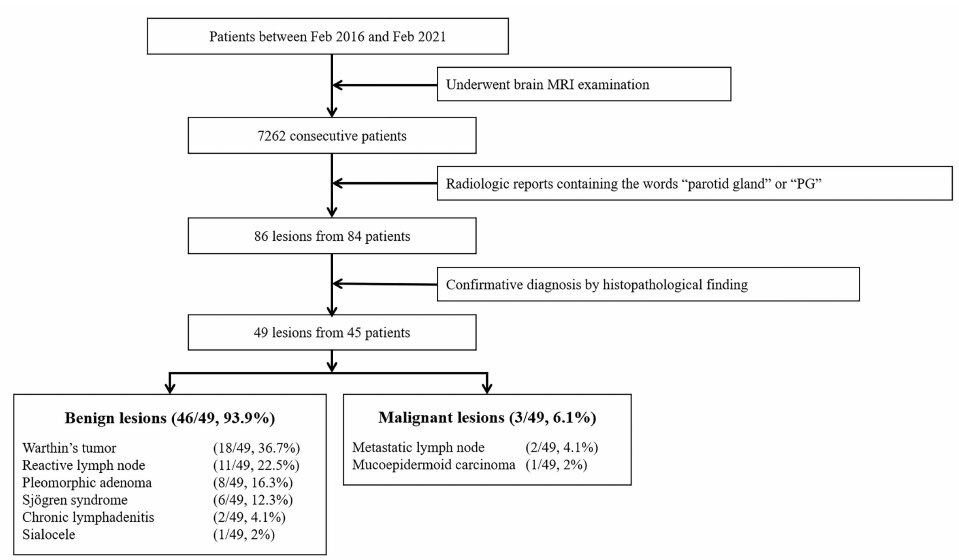
Figure 1. Flow chart. Magnetic resonance imaging